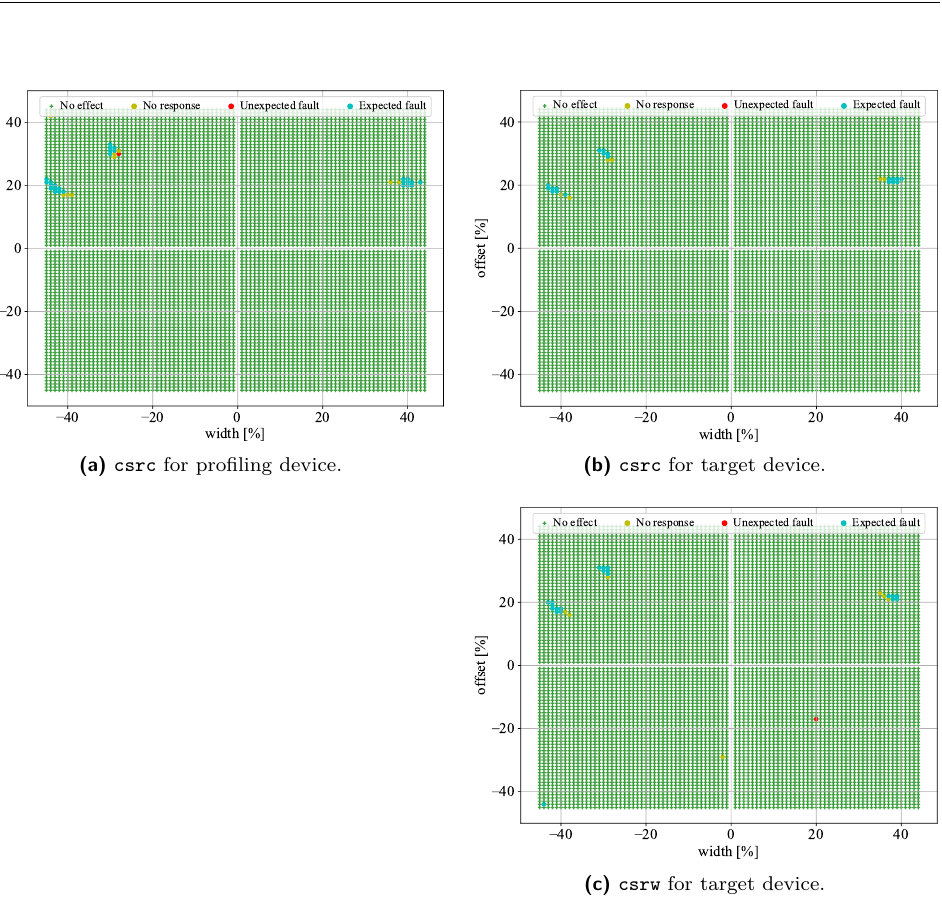
Figure 19: Profiling results for csrc . Result for csrw is for